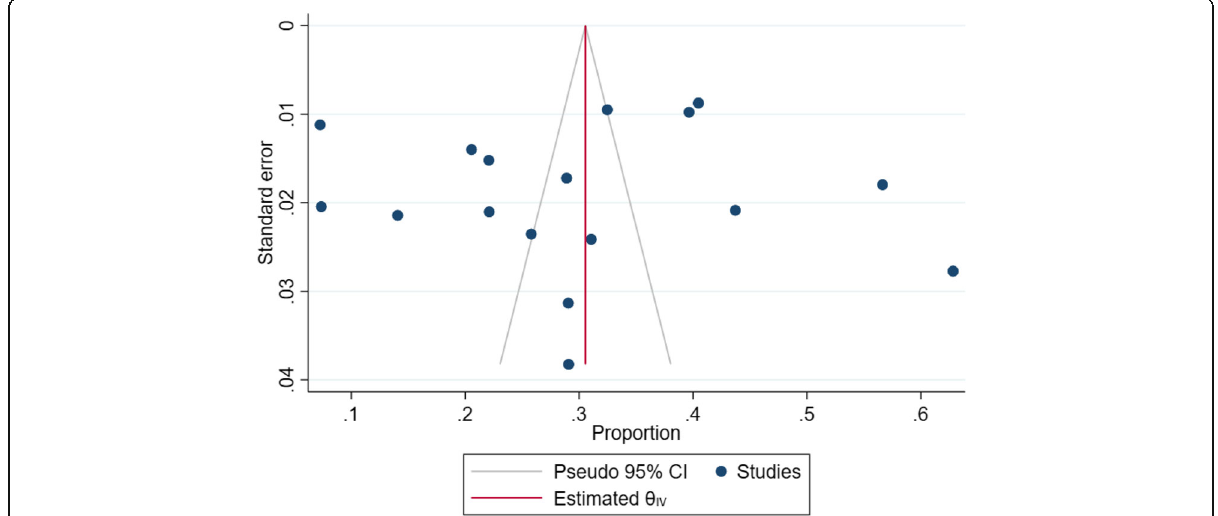
Fig. 3 Funnel plot of studies reporting prevalence of anemia in